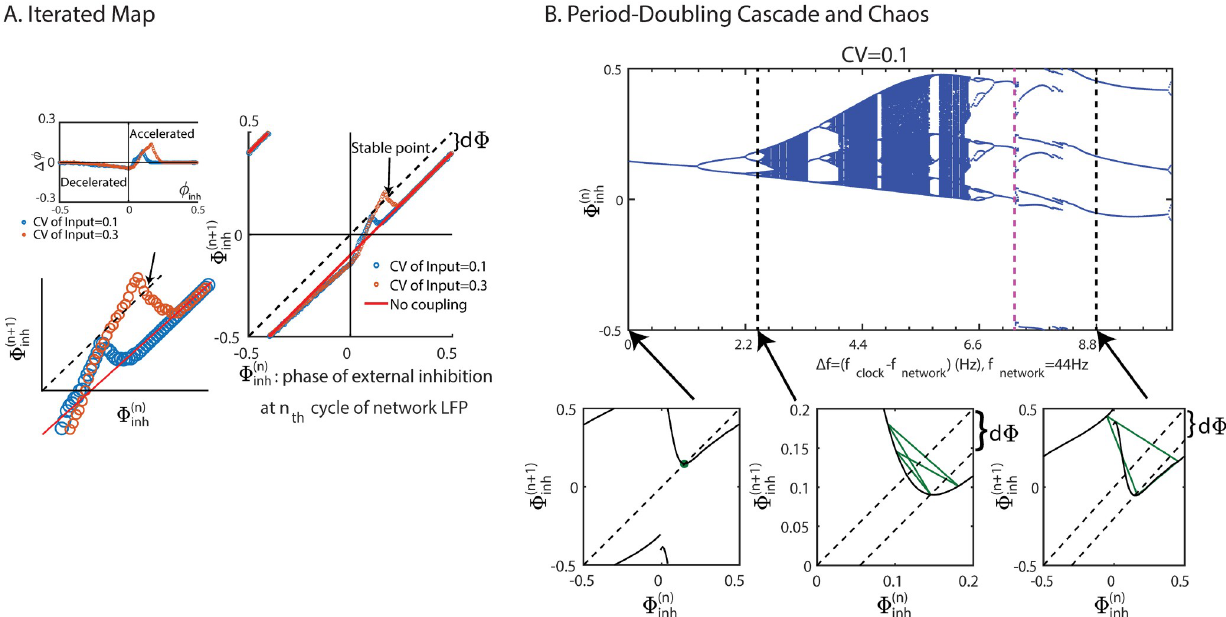
Fig 5. Connection between fmPRC and the synchronization of γ -rhythms. (A) Iterated map for the phase F ð n Þ inhibition. Without coupling the network falls back by d F in each cycle. For sufficiently large advancing phase response the network can be synchronized by faster periodic inhibition. (B) Top: The bifurcation diagram of the iterated map for F ð n Þ line ( Δ f = 7.28 Hz) the attractors involve points on both sides of the discountinuity of the map. Bottom from left to right: iterated maps for F ð n Þ 2.44, 8.8 Hz. The distance between the diagonal and subdiagonal line represents the detuning between the network and periodic input. In (A), the fmPRC was determined for a δ -pulse perturbation, in (B) for a double-exponential inhibitory current (cf. Eqs (2) and (3)) was used as in Fig 6.